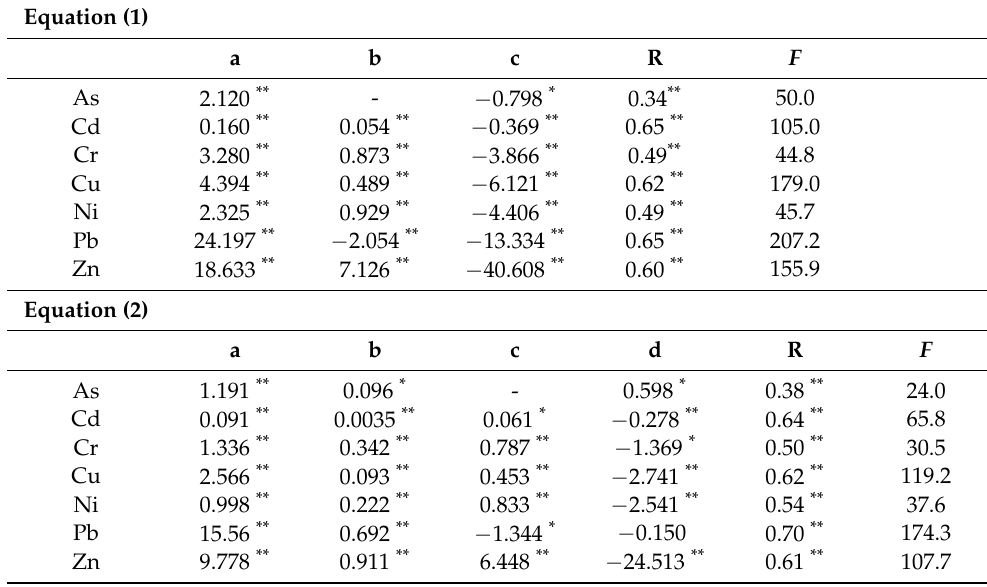
Table 1. Parameters of the multiple regression equations for the estimation of As, Cd, Cr, Cu, Ni, Pb and Zn concentrations in the topsoil (0–5 cm, 5–10 cm depth) from CEC eff , pH(KCl), C org and clay content; significance: * p < 0.05, ** p <